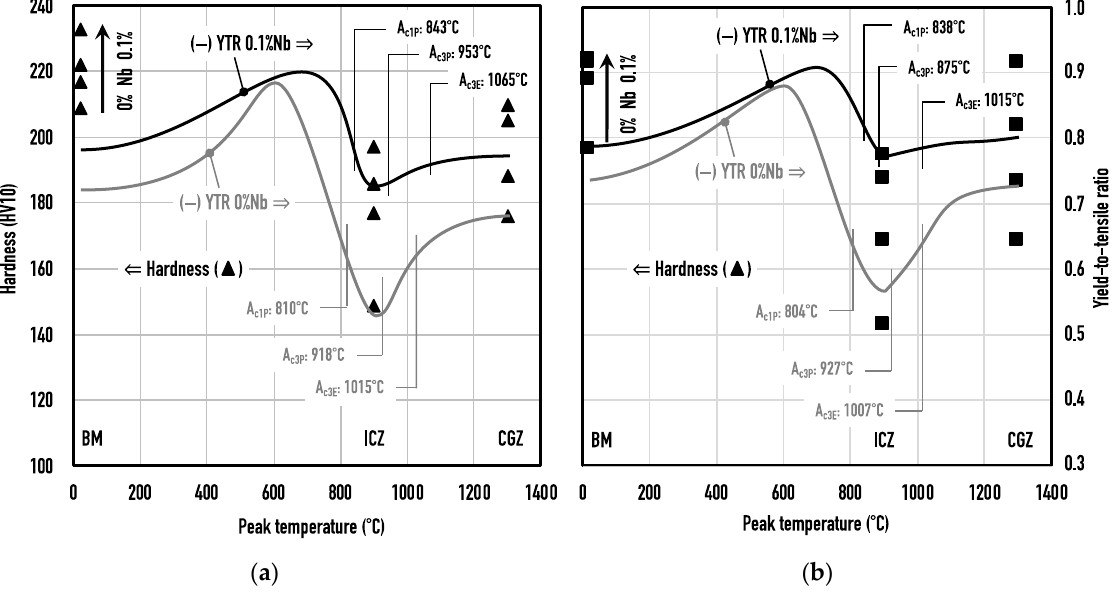
Figure 6. Evolution of hardness and yield-to-tensile ratio (YTR) in the heat-affected zone of ( a ) alloys V4; ( b ) alloys V6. Measured transformation temperatures during up-heating are indicated.